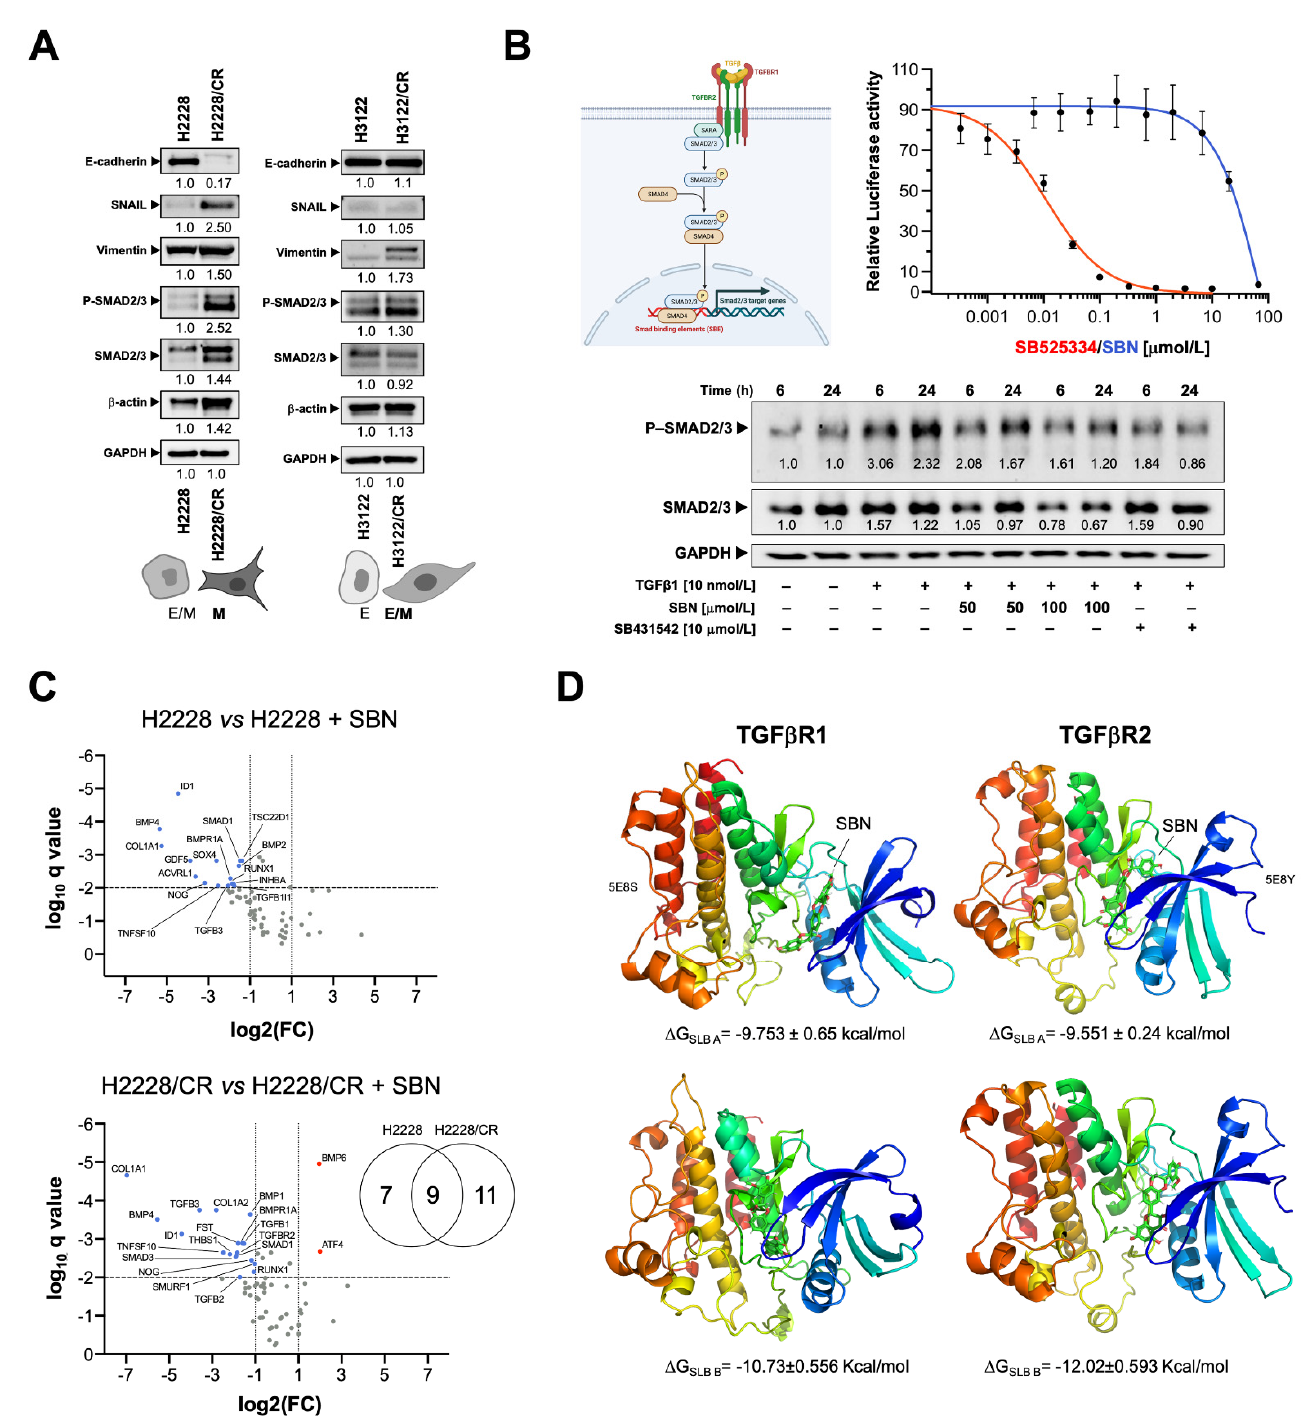
Figure 3. Targeted effects of silibinin against the TGF β /TGF β R/SMAD signaling pathway. ( A ) Ex- pression levels of E-cadherin, SNAIL, vimentin, phospho-SMAD2/3, total SMAD2/3 were detected by immunoblotting in H2228/H2228CR and H3122/H3122CR cells using specific antibodies. The intensity of the bands was measured using the ImageJ software. Fold-change of each protein relative to parental cells was calculated using GAPDH as a loading control. The figure shows representative immunoblots of multiple ( n ≥ 5) independent experiments. E: Epithelial; M: Mesenchymal. ( B ) Top: Relative luciferase activity using SBE Reporter–HEK293 cells pre-incubated during 4–5 h with graded concentrations of SB525334 and silibinin before stimulation with TGF β 1. Bottom: Expression levels of phospho ‐ SMAD2/3 and total SMAD2/3 were detected by immunoblotting in HEK293 cells stimulated with TGF β 1 (0, 6, and 24 h) in the absence/presence of either silibinin or SB431542 using